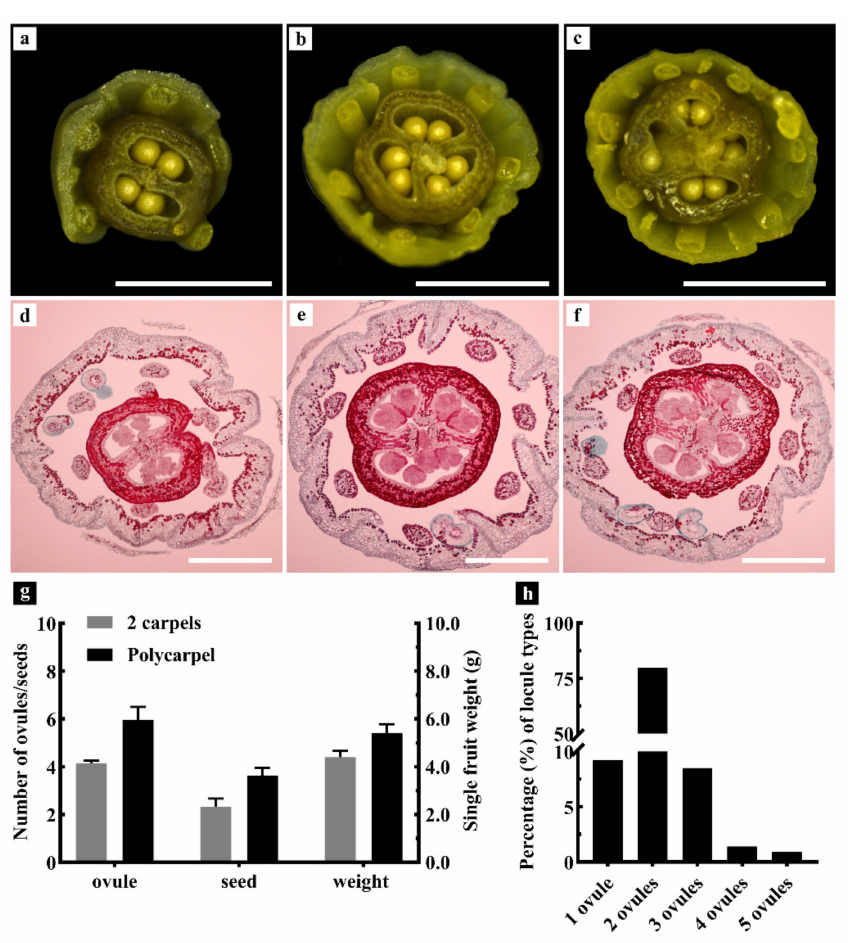
Figure 2. Observation and quantification of the ovule numbers of ‘Xiangfei’ grapes. ( a – c ) Ovules in 2, 3, and 4 carpellate florets on the inflorescence (one week before anthesis) were examined under a stereoscopic microscope, scale bars = 1 mm. ( d – f ) Paraffin slices. Ovules in 2, 3, and 4 carpellate florets on inflorescences of 8–12 cm long, scale bars = 100 µ m. ( g ) The number of ovules in 2-carpel and polycarpel florets, average fruit weight and number of seeds in 2-carpel and polycarpel fruits. Error bars indicate standard errors. ( h ) The proportions of locules with different ovule numbers ( n > 1000, ‘ n ’ represents the number of locules that were